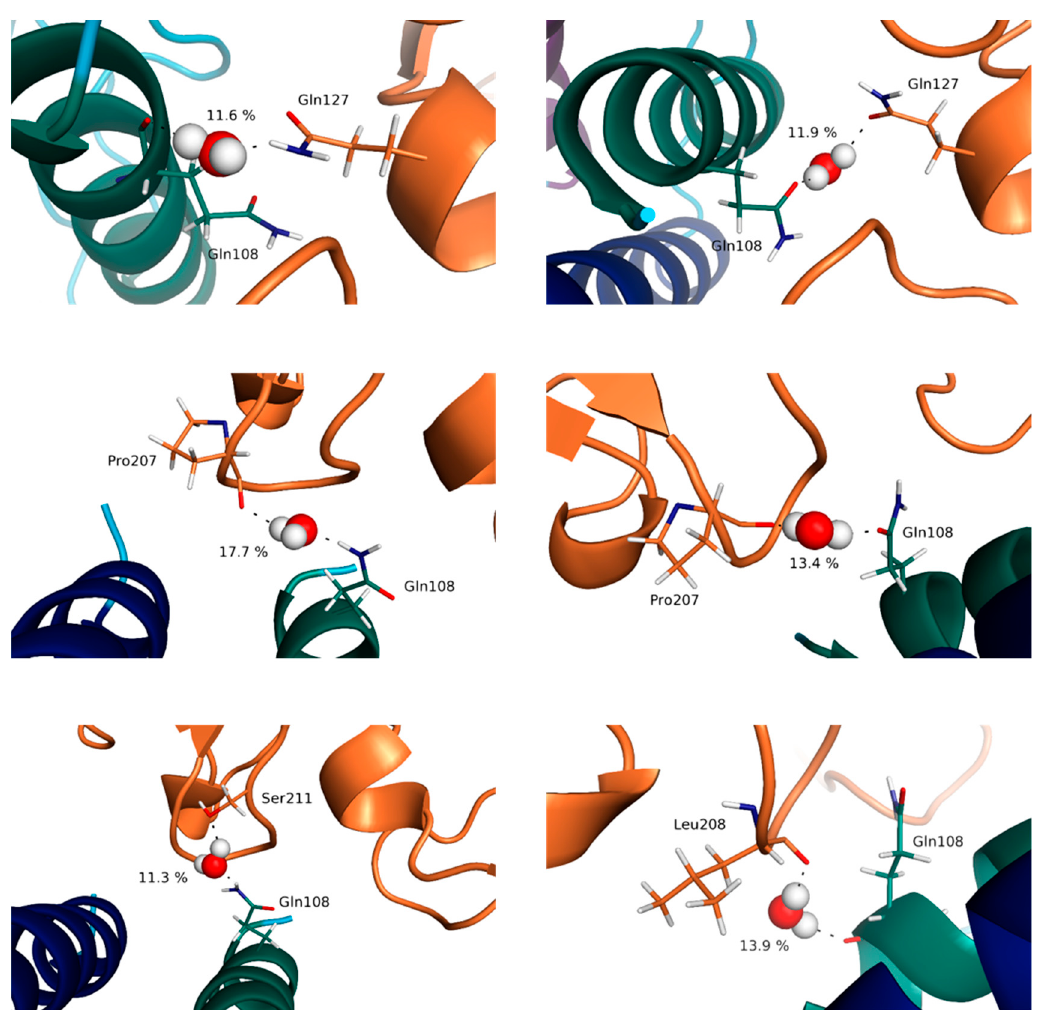
Figure 11. Representation of key bridging water molecules at the IL-15/ γ c interface for the full system ( left ) and the trimeric system ( right ). The values indicated correspond to the percentage of presence of the water molecules along the simulation time.